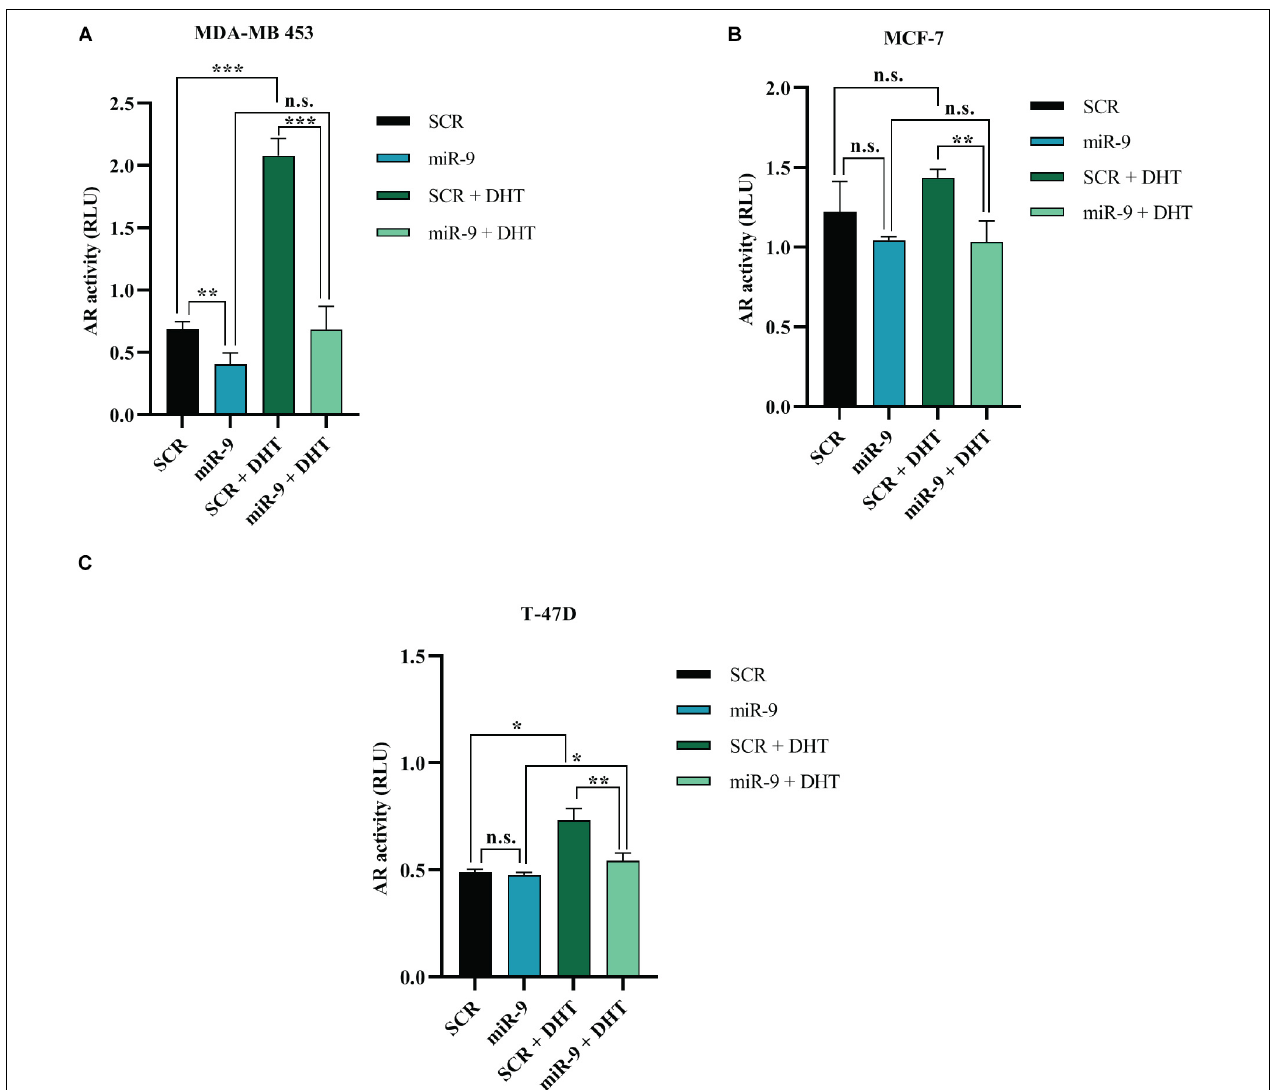
FIGURE 7 | Effects of miR-9-5p (mir-9) on AR signaling. AR transcriptional activity as measured with the AR Cignal reporter assay at 48 h in MDA-MB-453 (A) , MCF7 (B) , and T47D (C) cells. The modulation of AR transcription factor was determined by comparing the normalized luciferase activities of the reporter in treated vs. untreated transfectants (SCR vs. miR-9, SCR vs. SCR + DHT, miR-9 vs. miR-9+DHT, and SCR+DHT vs. miR-9+DHT), in all the BC cell lines MDA-MB-453 (A) , MCF-7 (B) , and T-47D (C) . Firefly: Renilla activity ratios were calculated from experimental and control transfections. Then, ratios from AR responsive reporter transfections were divided by ratios from negative controls to obtain relative luciferase units (RLU). * p < 0.05, ** p < 0.01, *** p < 0.001, n.s., not significant. Multiple t -test, corrected for multiple comparison using the Holm-Sidak method in (A–C)